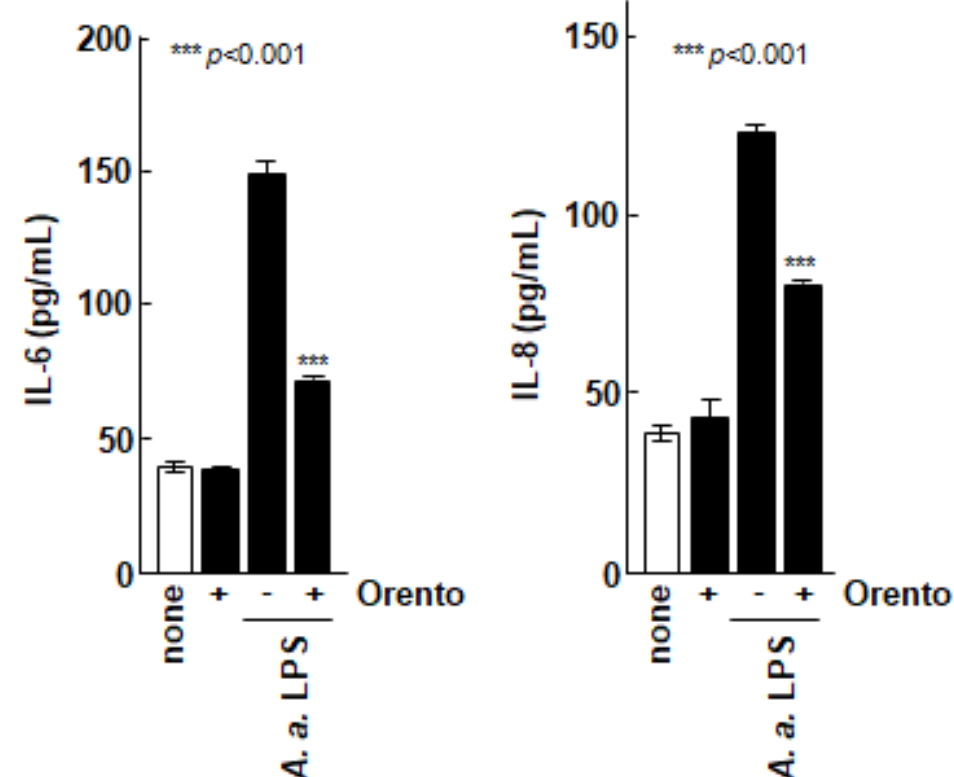
ff ect of orento on inflammatory cytolysis of Saos-2 cells. *** is p < Figure 2. Effect of orento on inflammatory cytolysis of Saos-2 cells. *** is p < 0.001. Figure 2. E